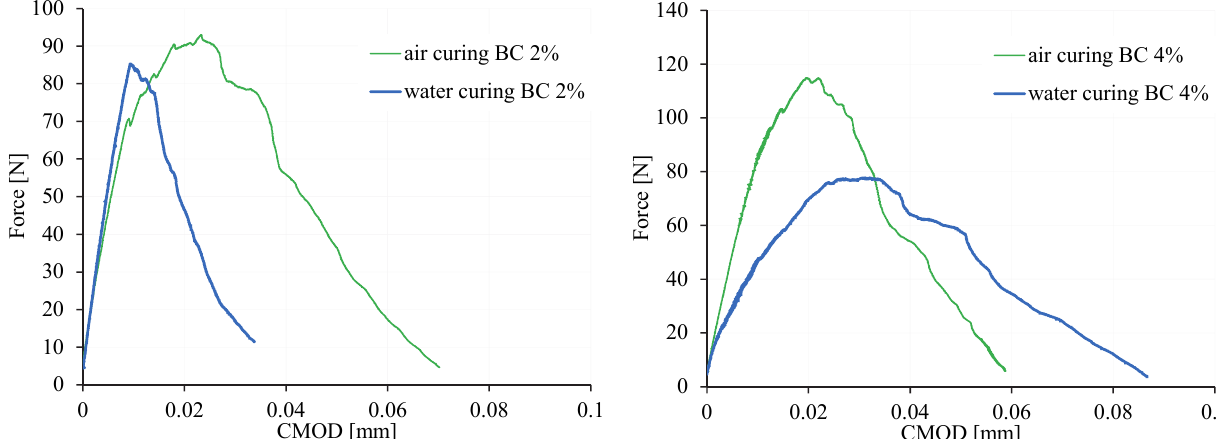
Figure 5: Comparative histograms of average fracture energy of foamed concrete specimens with different curing conditions and biochar contents.